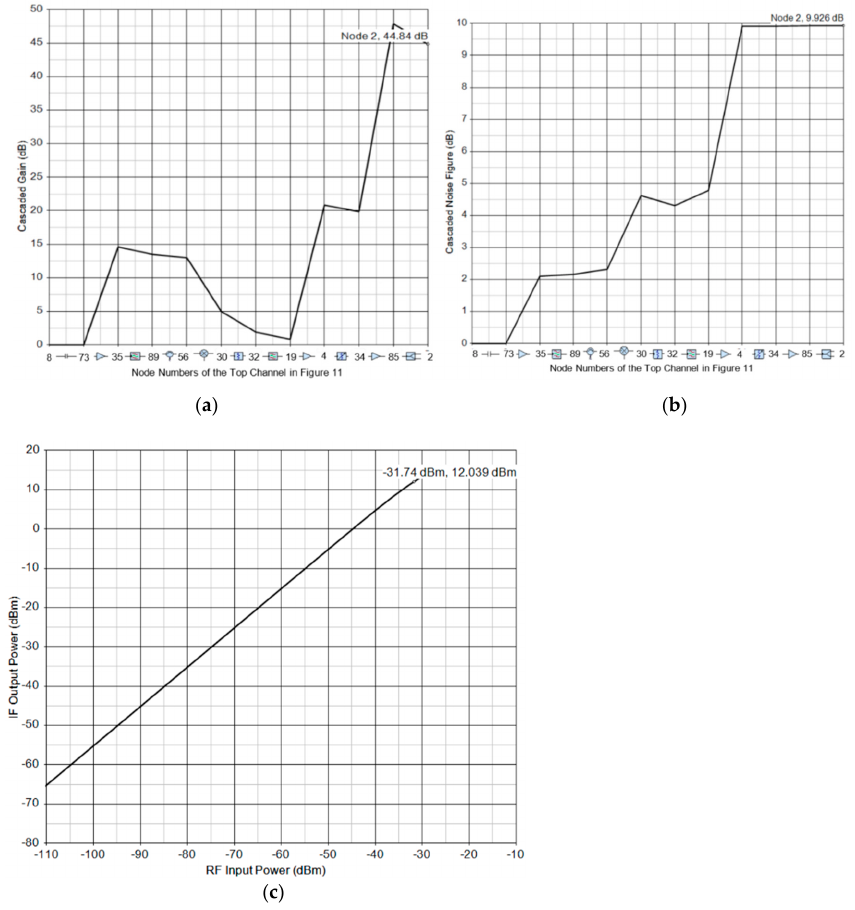
Figure A6. ( a ) The RF down-converter cascaded gain, ( b ) cascaded noise figure, ( c ) compression curve, from RF frequency 3580 MHz to 100 MHz IF frequency.